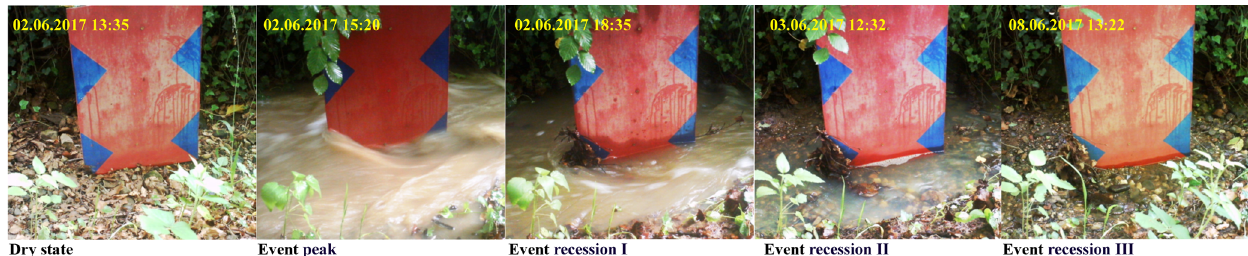
Figure 2. Example of streamflow event classification (site ID: C34) with change from dry to wet state and back. The event starts between 13:35 and 15:20 on 2 June 2017. Images taken between the time steps of dry conditions and event peak have been automatically identified by the software as being too noisy. Flow decreases during the event recession and ends on 10 June 2017.